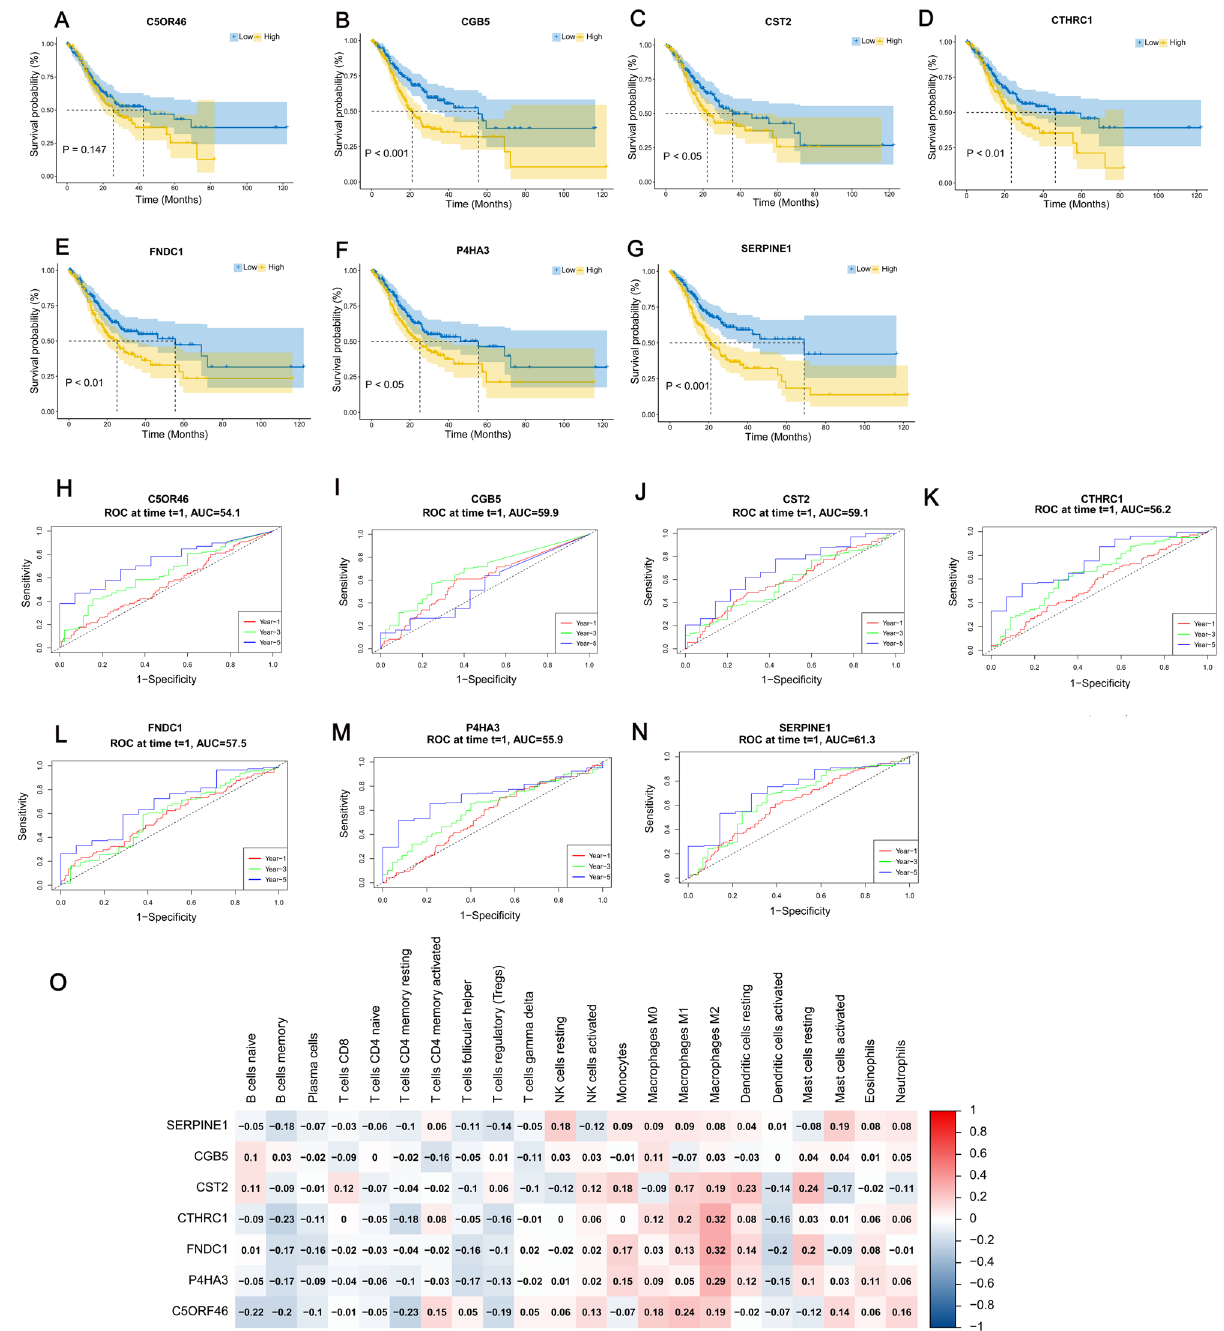
Figure 3. Survival and Prognostic Analysis graphs and heat map for correlation analysis of hub genes. ( A – G ) Kaplan–Meier survival curves of 7 hub genes. The horizontal axis indicates the overall survival time in months, and the vertical axis represents the survival rate. P value < 0.05 was considered statistically significant. ( H – N ) Time-dependent ROC curves of 7 hub genes. Time-dependent ROC curves illustrate the prognostic value of the7 hub genes. ( O ) Heat map of correlation between 7 hub genes and immune cell. The heatmap was created by using “pheatmap” package in R4.1.2 (https:// www.r- proje ct.